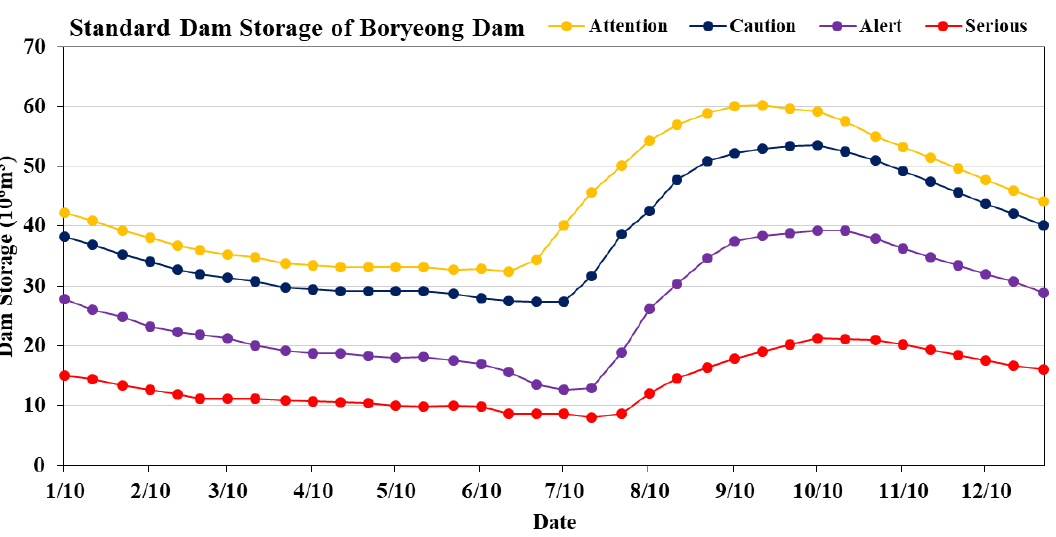
Figure 6. The reservoir management standard for Boryeong Dam with 4 stages dam storage conditions: attention, caution, alert, and serious. Table 6. The dam water supply plan when reservoir storage is under drought conditions.